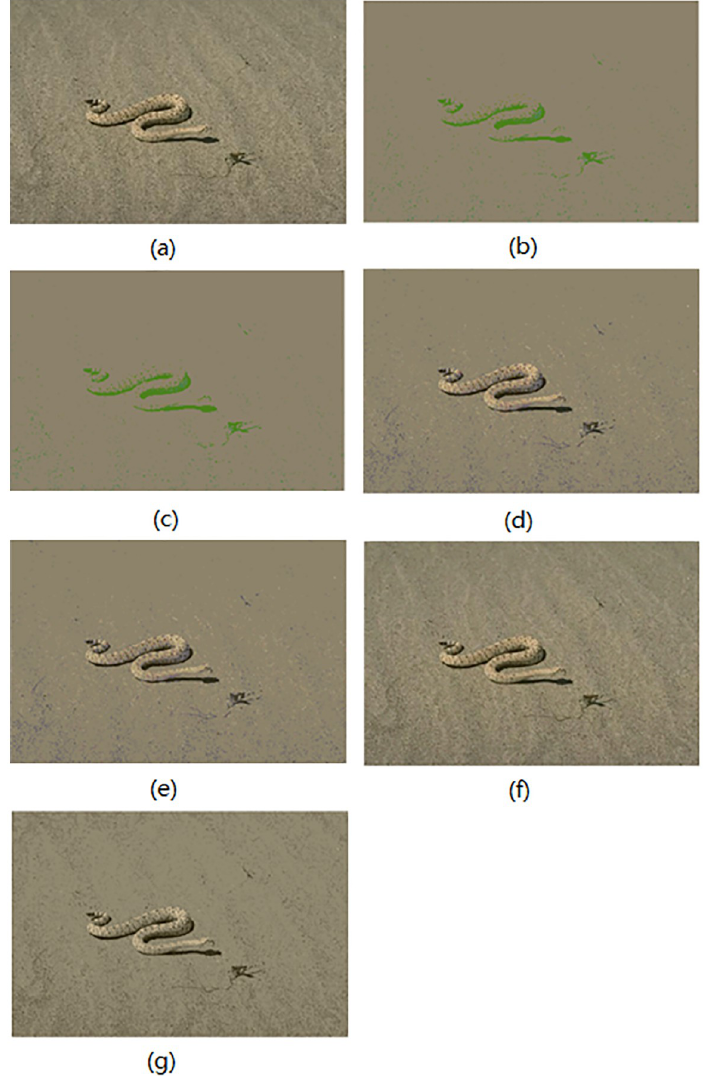
Fig 9. The image Snake : (a) original image, (b, c) initial segmented result and result after region merging based on the histon, (d, e) initial segmented result and result after region merging based on the roughness index, (f, g) initial segmented result and result after region merging based on AHHT